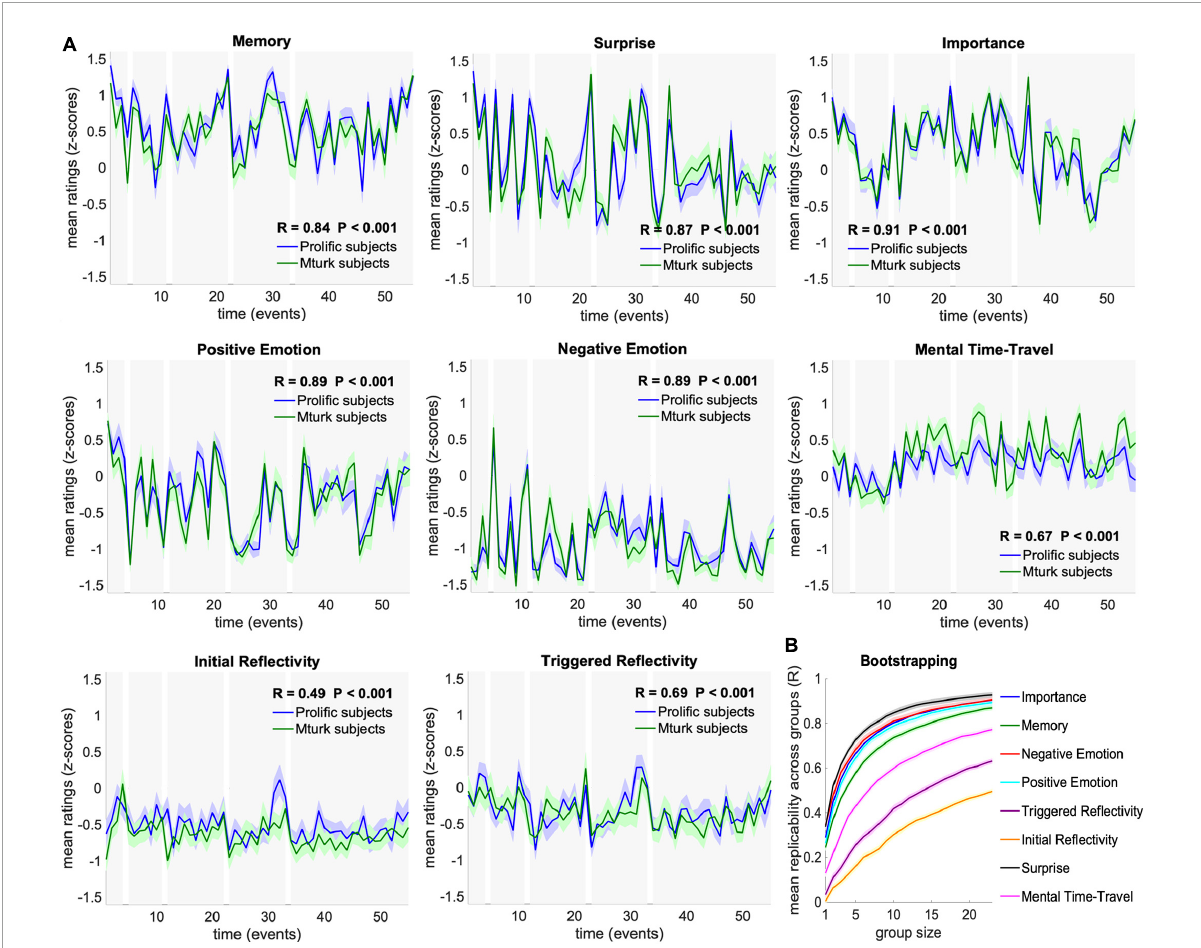
FIGURE2 Replicability and stability of cognitive dynamics. (A) Comparison of mean ratings across subjects between Group I–Mturk subjects (green; N = 26), and Group II–Prolific subjects (blue; N = 27). Dynamics were significantly correlated between groups in all tested cognitive measures (FDR corrected P < 0.001). Ratings are presented as mean and SEM across subjects. (B) Stability of group dynamics as a function of group size in a 100-iterations bootstrapping procedure. Each iteration randomly assigned 23 participants to each of two independent groups and tested the correlation across group means for each group size between 1 and 23. Bootstrapping results are presented as mean and SEM across sampling